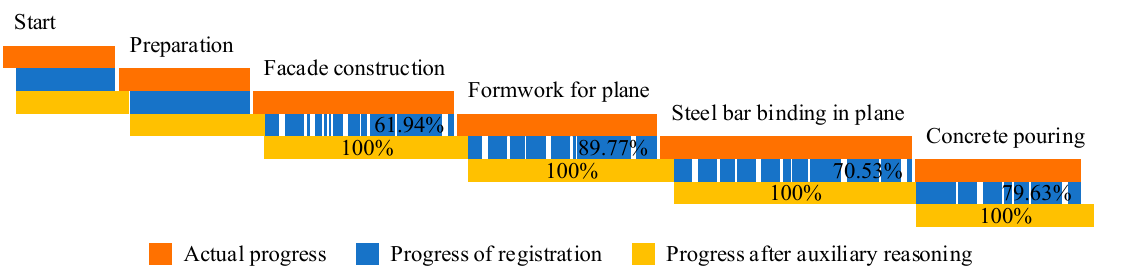
Figure 9. Comparison of construction progress.